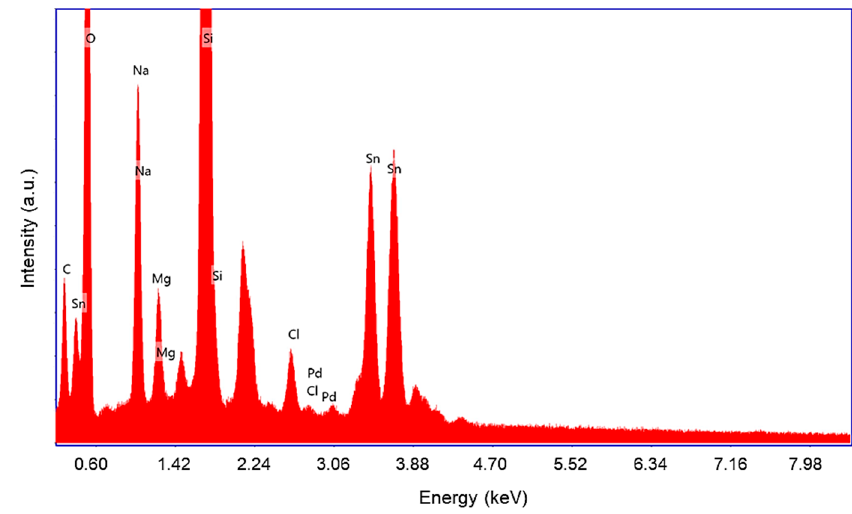
Figure 5. Typical EDX spectra recorded on the transferred Pd-SnO 2 pixels.